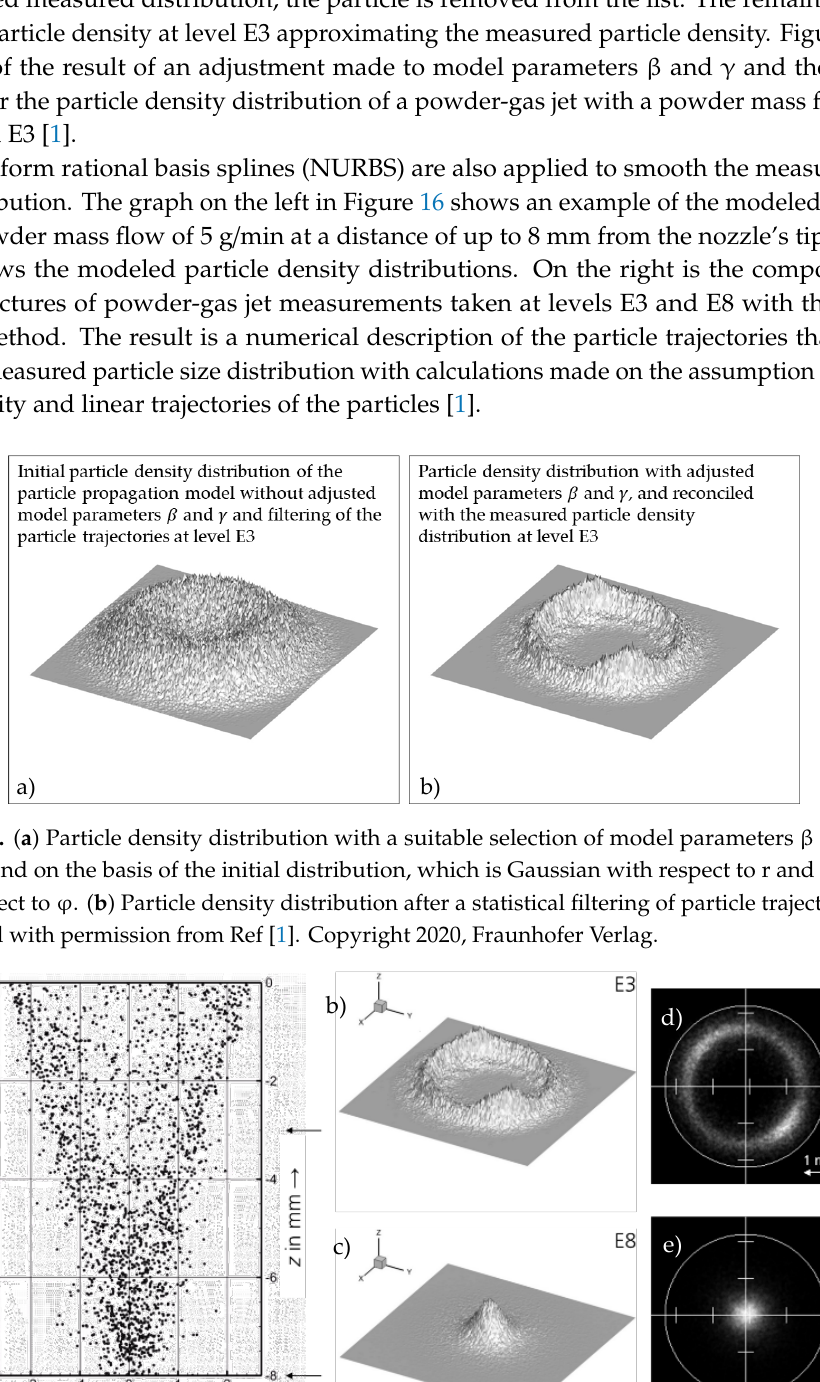
Figure 14. Diagram of the parameters for the particle propagation model. Left: Description of the powder particle density distribution with polar coordinates (r,Φ). Right: Model parameters for adjusting the angles inclination with respect to the z-axis: β and the x-y-axis: γ [1]. Reprinted with permission from Ref [1]. Copyright 2020, Fraunhofer Verlag.